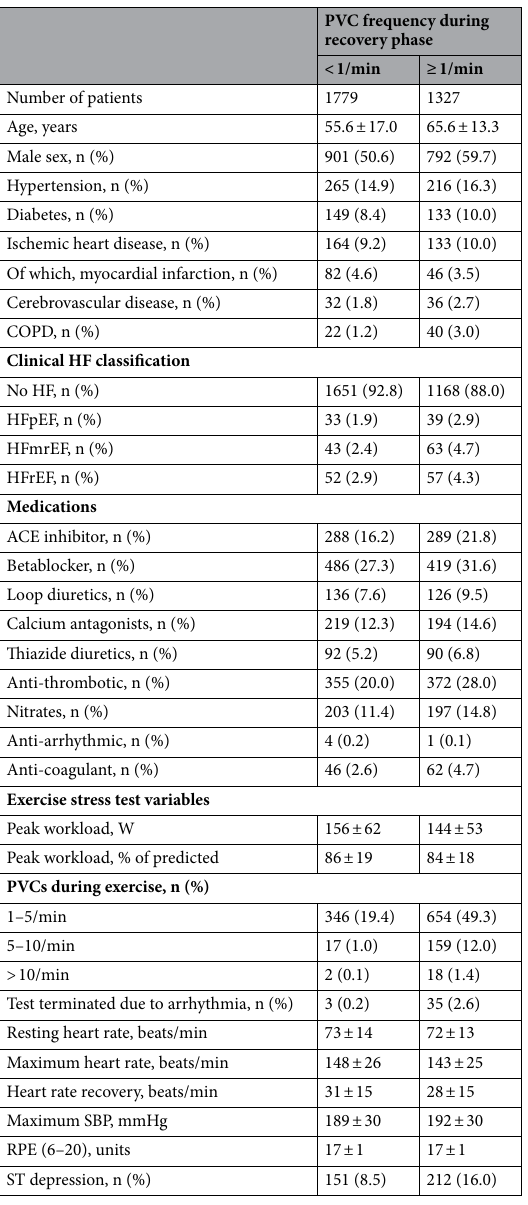
Table 1. Baseline characteristics including exercise stress test characteristics stratified by frequency of premature ventricular contractions during the recovery phase. Data presented as mean ± standard deviation